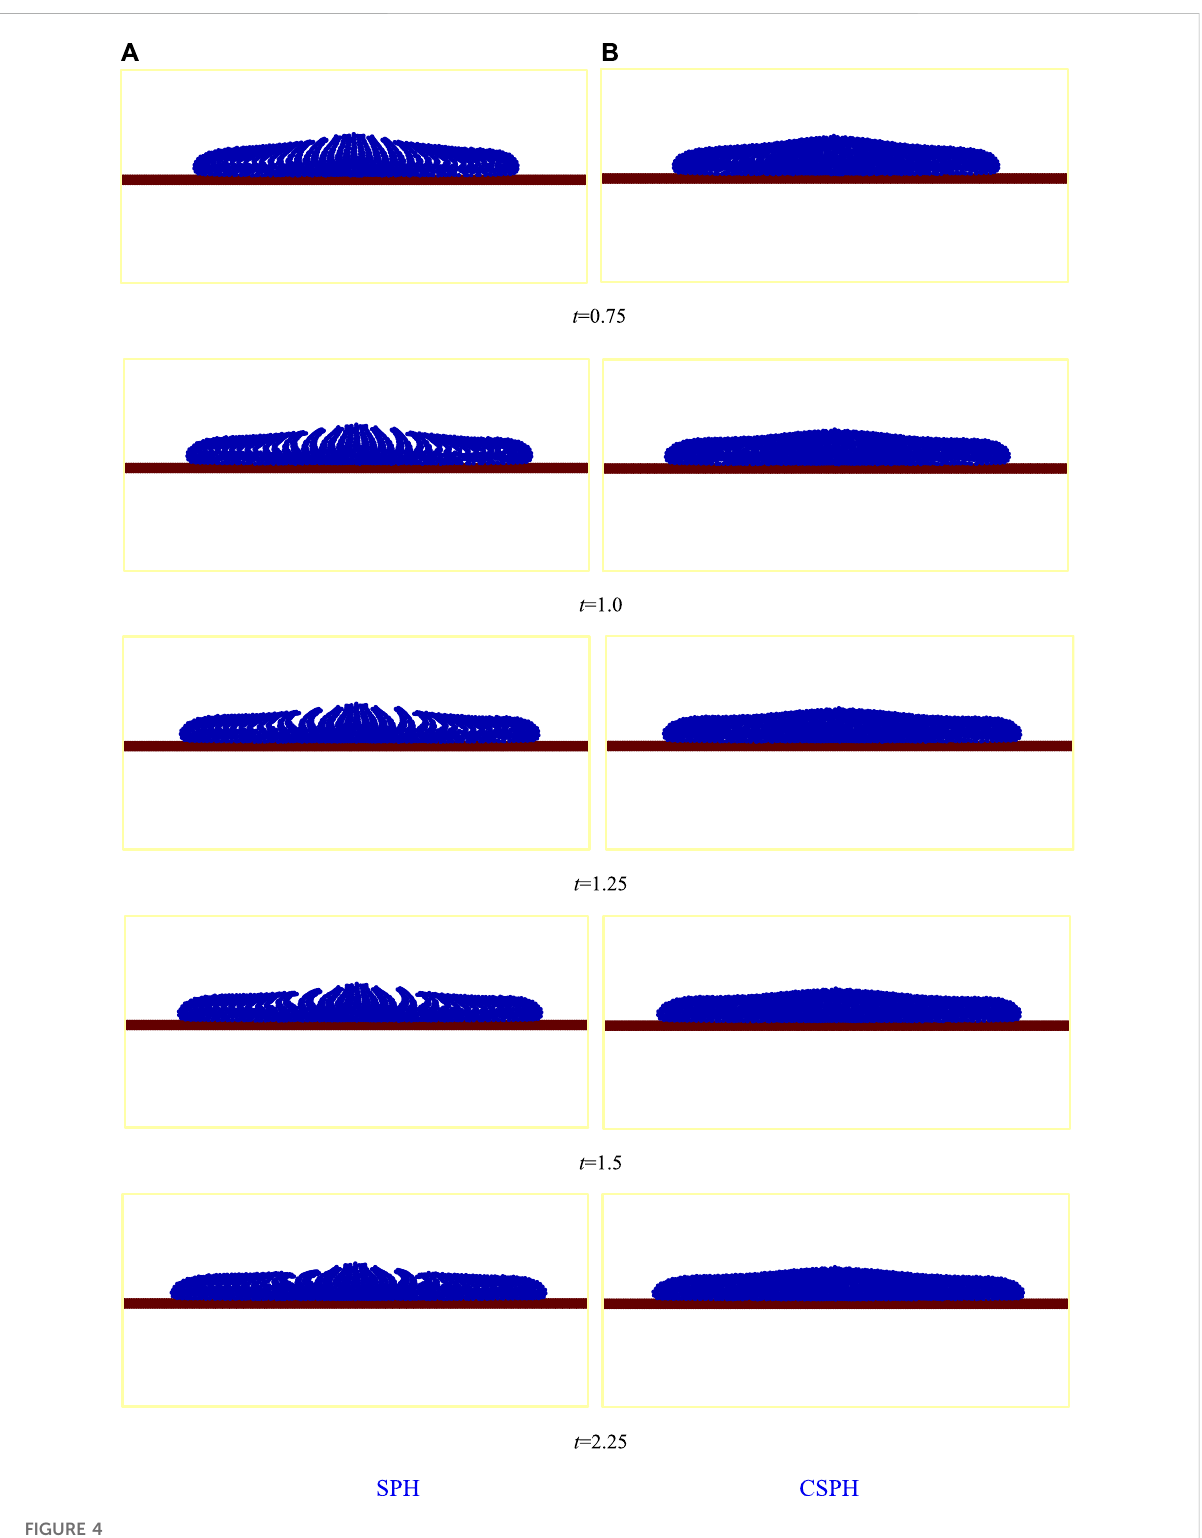
FIGURE 4 Bingham droplet impacting the horizontal solid wall with SPH and CSPH: (A) SPH and (B)